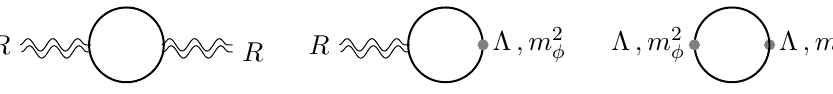
Figure 1 . Schematic of the UV divergent curvature terms at one